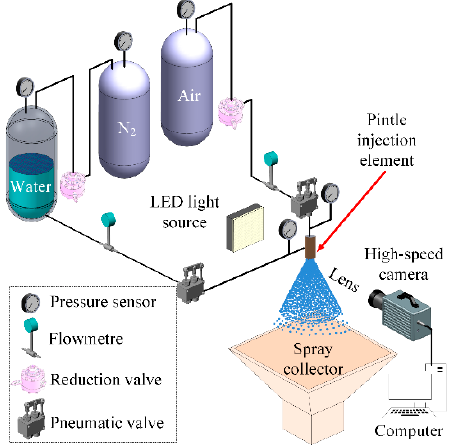
Figure 1. Schematic diagram of the experimental platform.